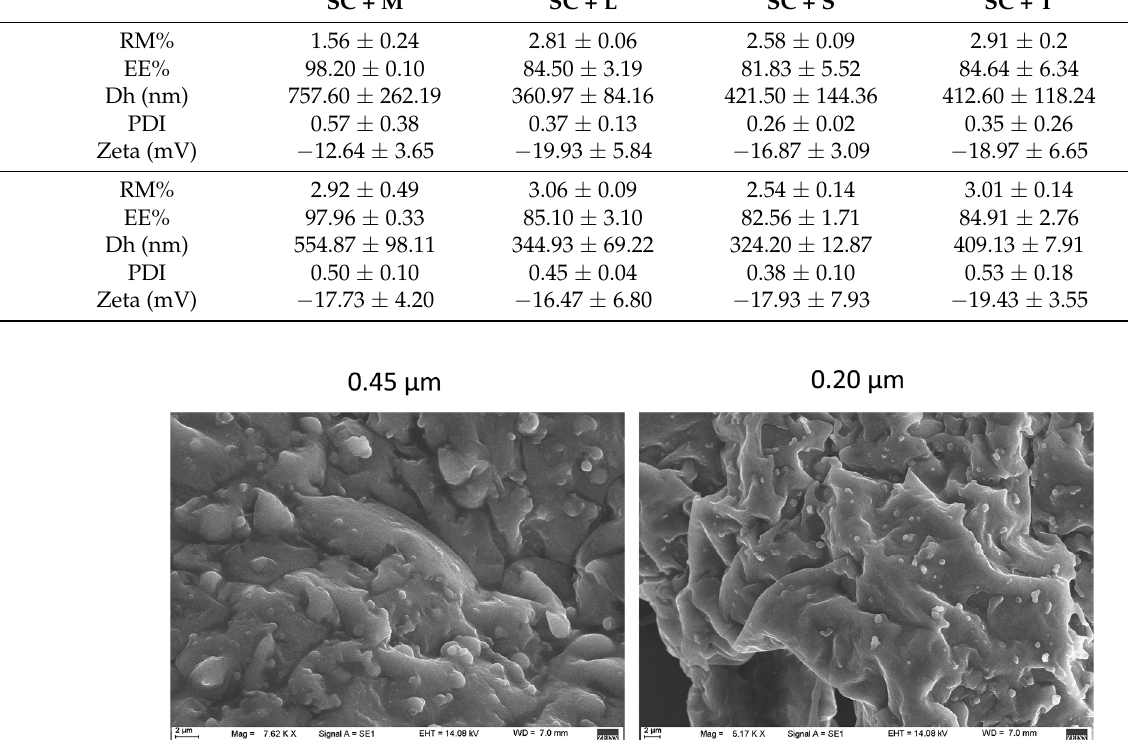
Table 3. Influence of additives on results obtained in the final lyophilization cycle (freezing at − 80 ◦ C; 24 h of primary drying and 20 h of secondary drying at 20 ◦ C). RM: remaining moisture in dry cake; EE, Dh, PDI, and Zeta: entrapment efficiency, size, polydispersity index, and zeta potential of rehydrated liposomes, respectively (SC + M, SC + L, SC + S, and SC + T: sildenafil citrate liposomes lyophilized with mannitol, lactose, sucrose, and trehalose, respectively). SC + M